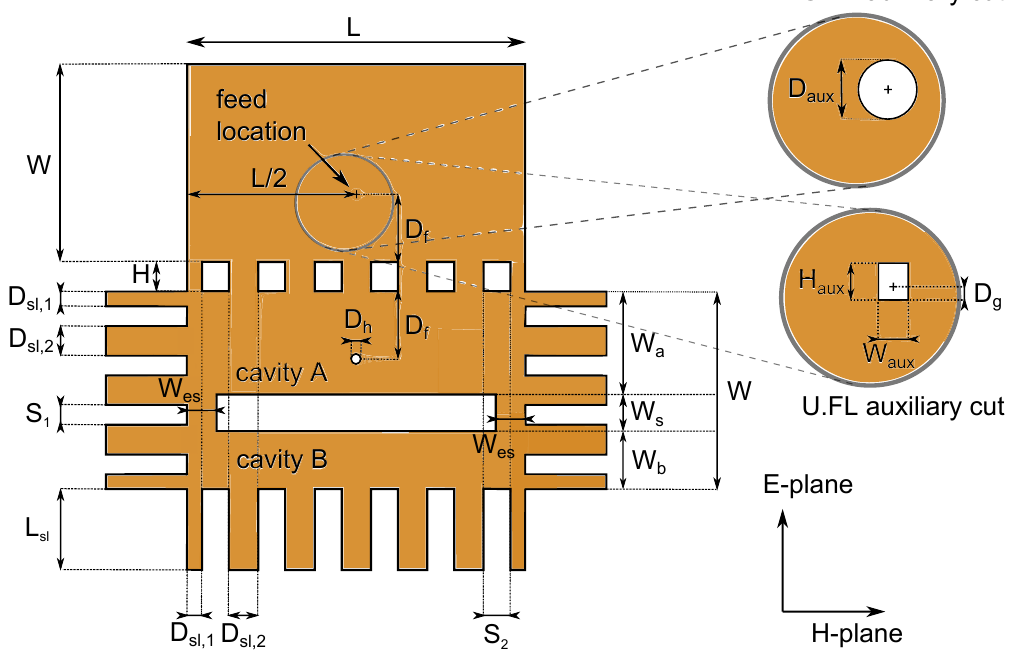
Figure 3. Optimized dimensions of the laser cut shape: H = 4 mm,W = 26.84 mm,L = 45.94 mm,W a = 16.49 mm,W b = 10.35 mm,W es = 4 mm,W s = 5 mm,D f = 9.22 mm,D h = 0.65 mm,D aux = 5 mm,H aux = 2.85 mm,W aux = 1.94 mm,D g = 0.9 mm,L sl = 11 mm,D sl,1 = 2 mm,D sl,2 = 4 mm,S 1 = 2.71 mm,S 2 = 4